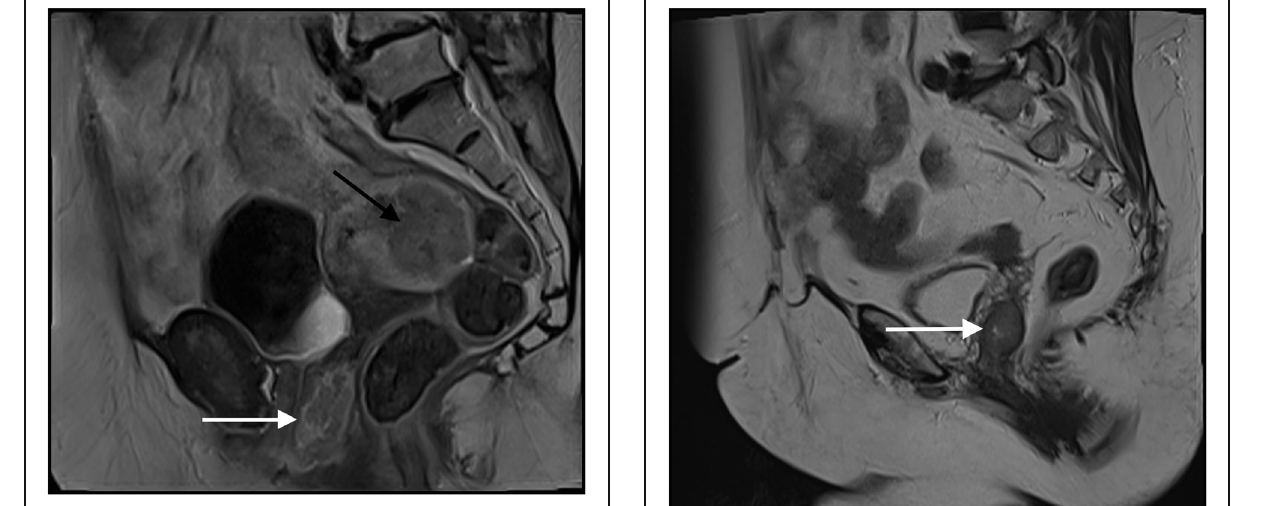
Fig. 1 Sagittal T1-weighted image obtained after administration of contrast material demonstrates endometrial mass (black arrow) with heterogeneously enhanced vaginal metastasis (white arrow)